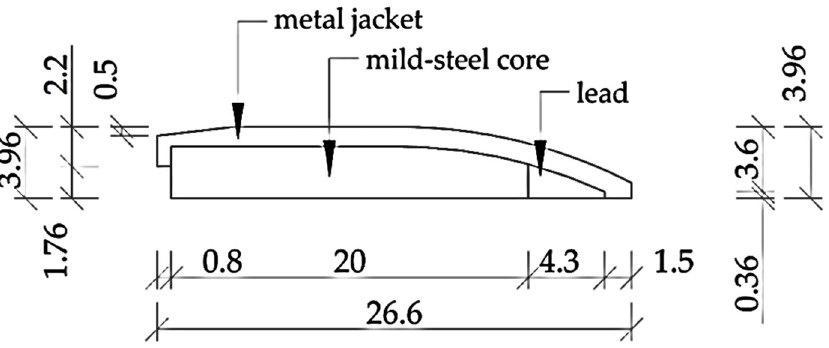
Figure 5. Ballistic test schematics; (1) Shooter, (2) Chronograph, (3) Test specimen, (4) Specimen mounting structure.